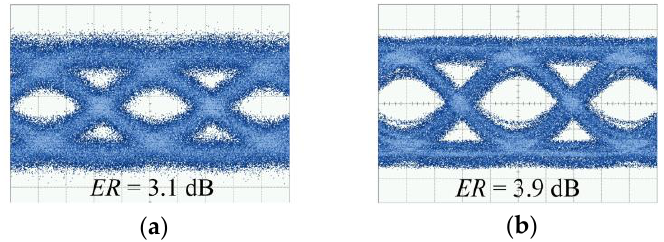
Figure 5. The 25 Gbps eye patterns of modulated light: ( a ) ML = 0.5 dB and ( b ) 1.0 dB with PRBS lengths of 2 31 − 1 and 2 7 − 1, respectively.